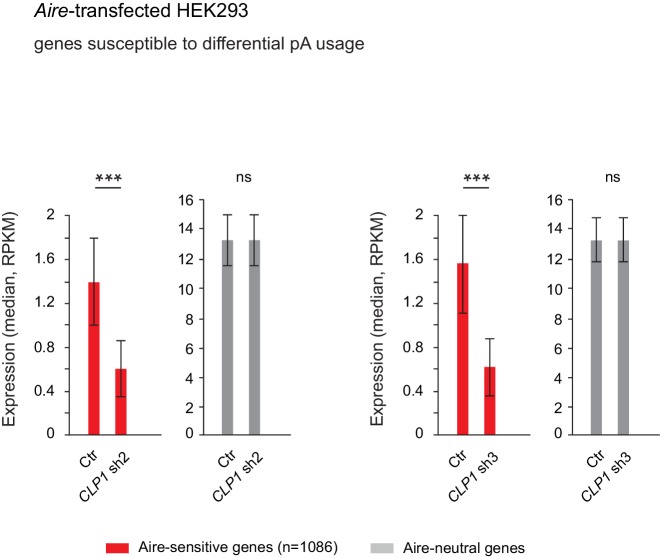
Impact of CLP1 knockdown on the expression levels of Aire-sensitive genes in Aire-transfected HEK293 cells.Median of expression values from RNA-seq data of Aire-sensitive and neutral genes in Aire-transfected HEK293 cells infected by lentiviruses containing CLP1 hit shRNAs (sh2 Left, sh3 Right) or the Ctr (LacZ) shRNA. The Aire signature was defined through differential expression (FC >2.2, Z-score criterion of p<0.01) with AIRE-negative HEK293 cells transfected with the Ctr plasmid; same neutral genes than in Figure 3D
Right, error bars show the 95% confidence interval of the medians. ***p<0.0005.